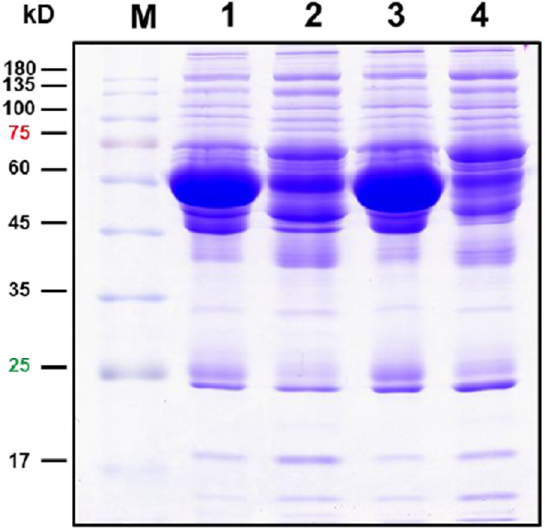
Figure 1. Protein profiles on SDS-PAGE. Here, 30 µ g proteins were electrophoresed on 12.5% SDS- PAGE, and the proteins were visualized by Coomassie brilliant blue staining. Lane 1, original serum of AAD patients; Lane 2, depleted serum of AAD patients; Lane 3, original serum of AMI patients; Lane 2, depleted serum of AMI patients. Table 2. Summary of proteins identified in serum samples from AAD and AMI. Identified Proteins